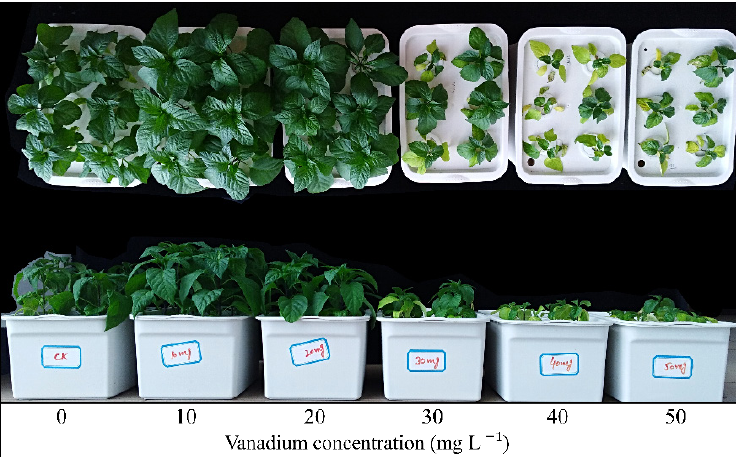
Figure 1. Visual demonstration of pepper seedlings under vanadium toxicity. The calculation for GTI, by using Equations (1) and (2), was shown in Table 1. GTI S